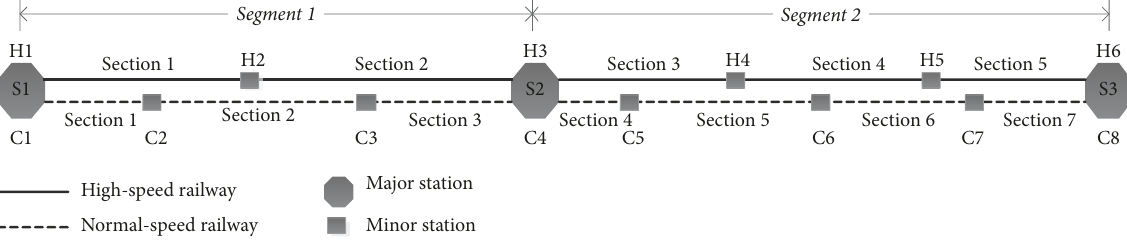
Figure 2: A high-speed railway corridor and its parallel normal-speed railway corridor.